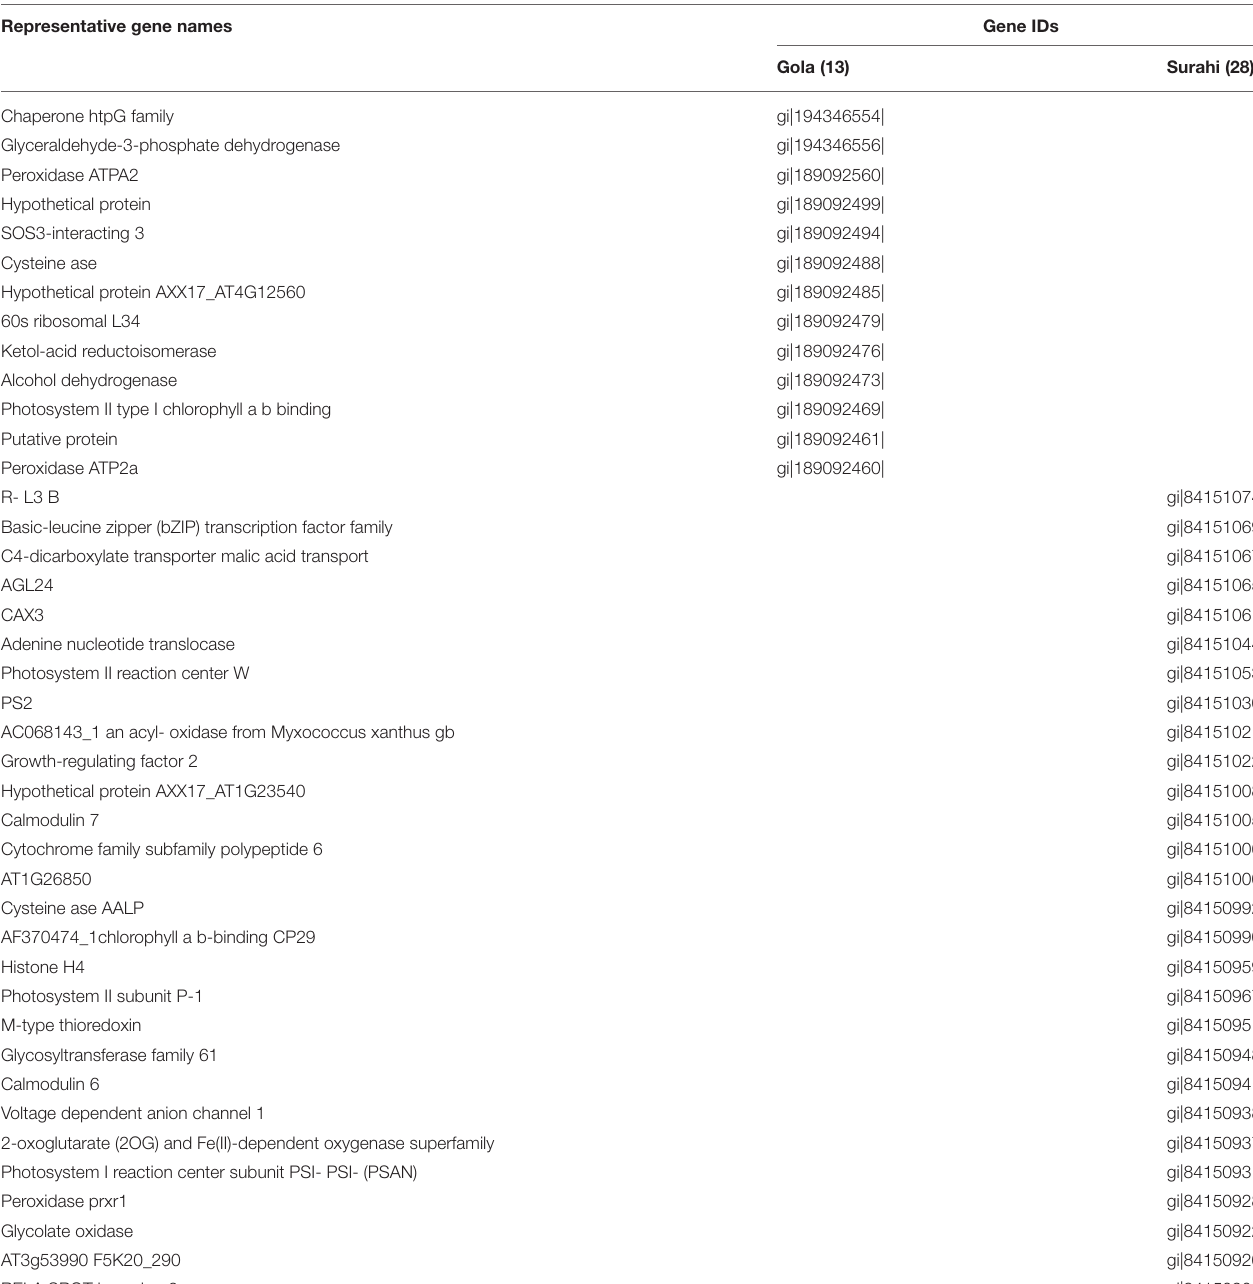
TABLE 9 | Number of different ESTs downregulated in “Gola” and “Surahi” cultivars under drought